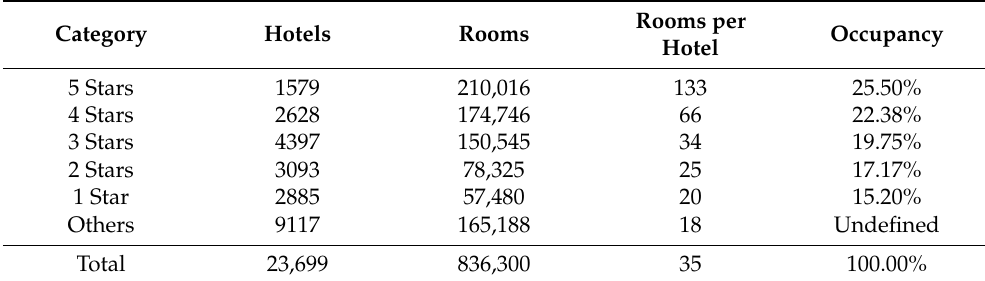
Hospitality structure and topology for Mexico (table developed with data from SECTUR [20] (December